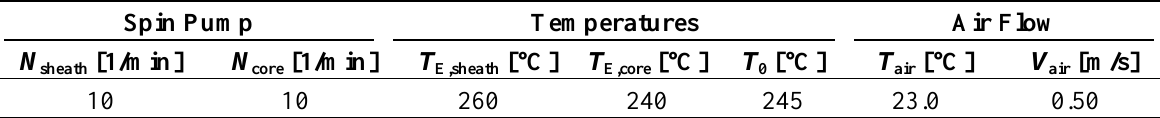
Table 1. Process parameters for bicomponent melt spinning.